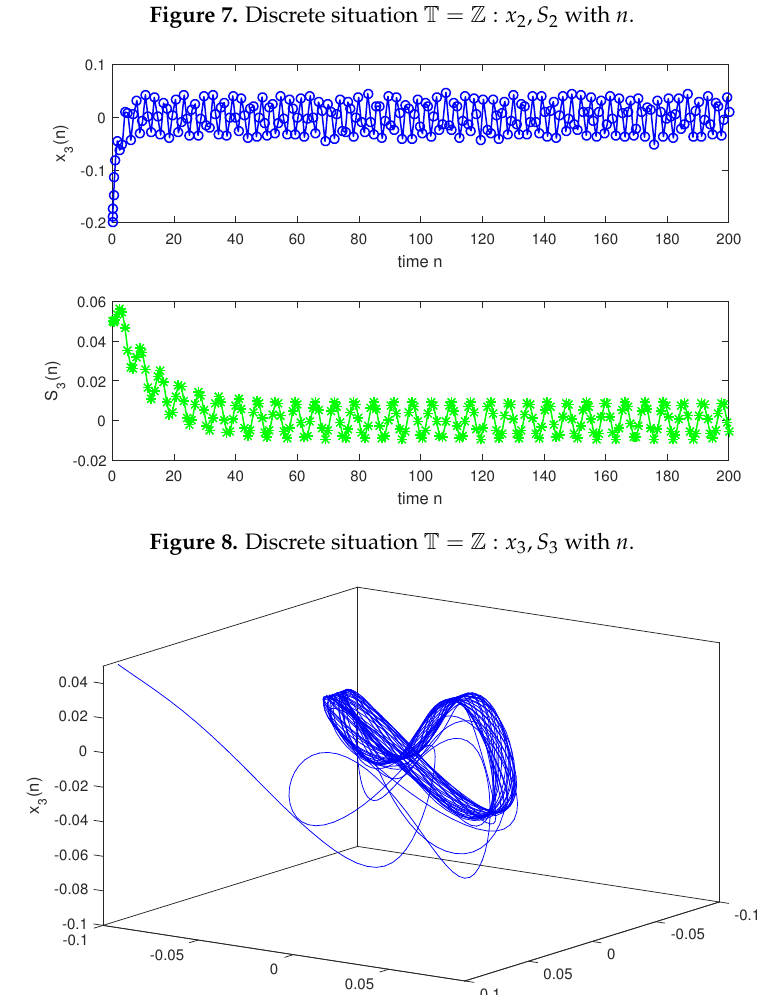
Figure 7. Discrete situation T = Z : x 2 , S 2 with n .